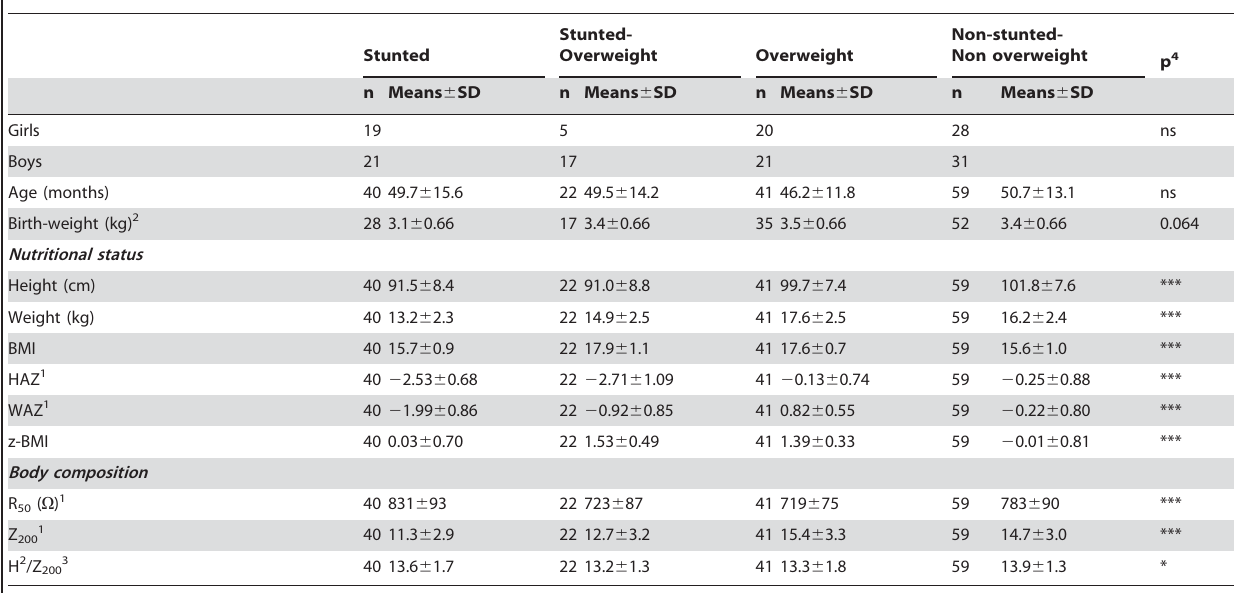
Table 1. Characteristics of the four groups of subjects.